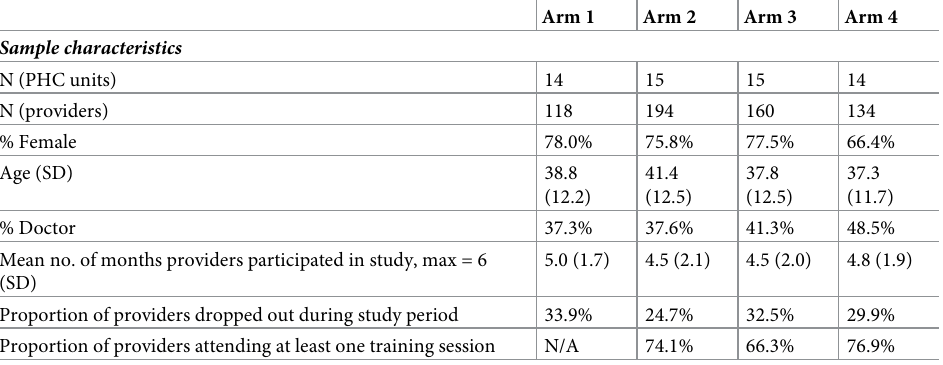
Table 1. Characteristics of participating